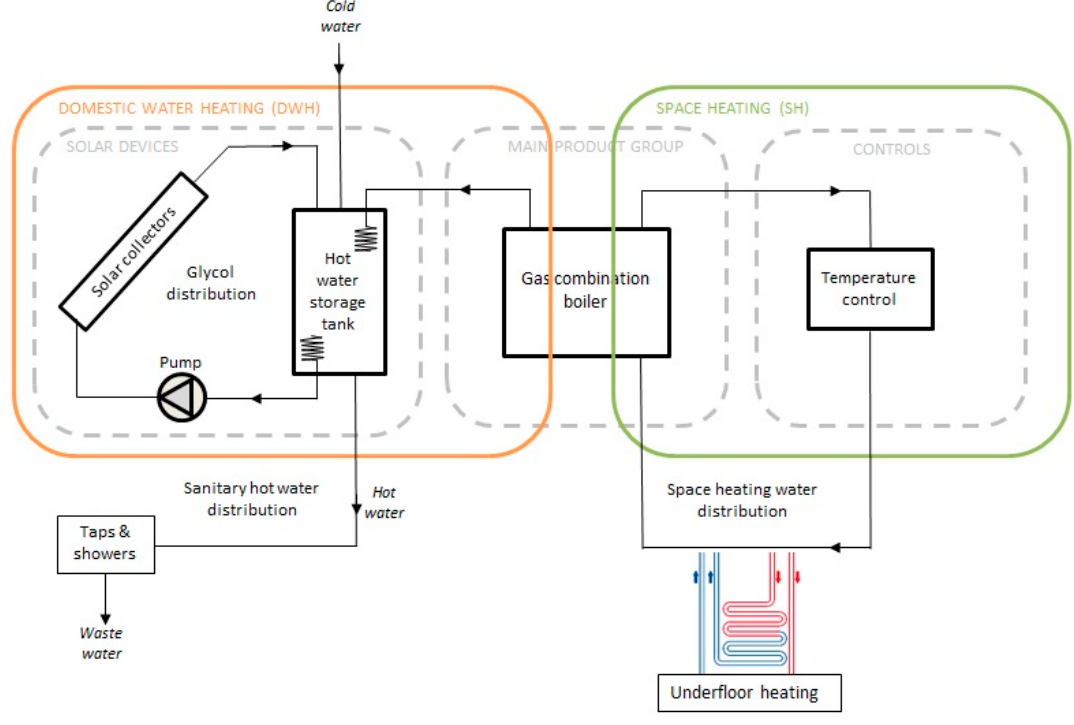
Figure 5. Heating systems considered in the case study.